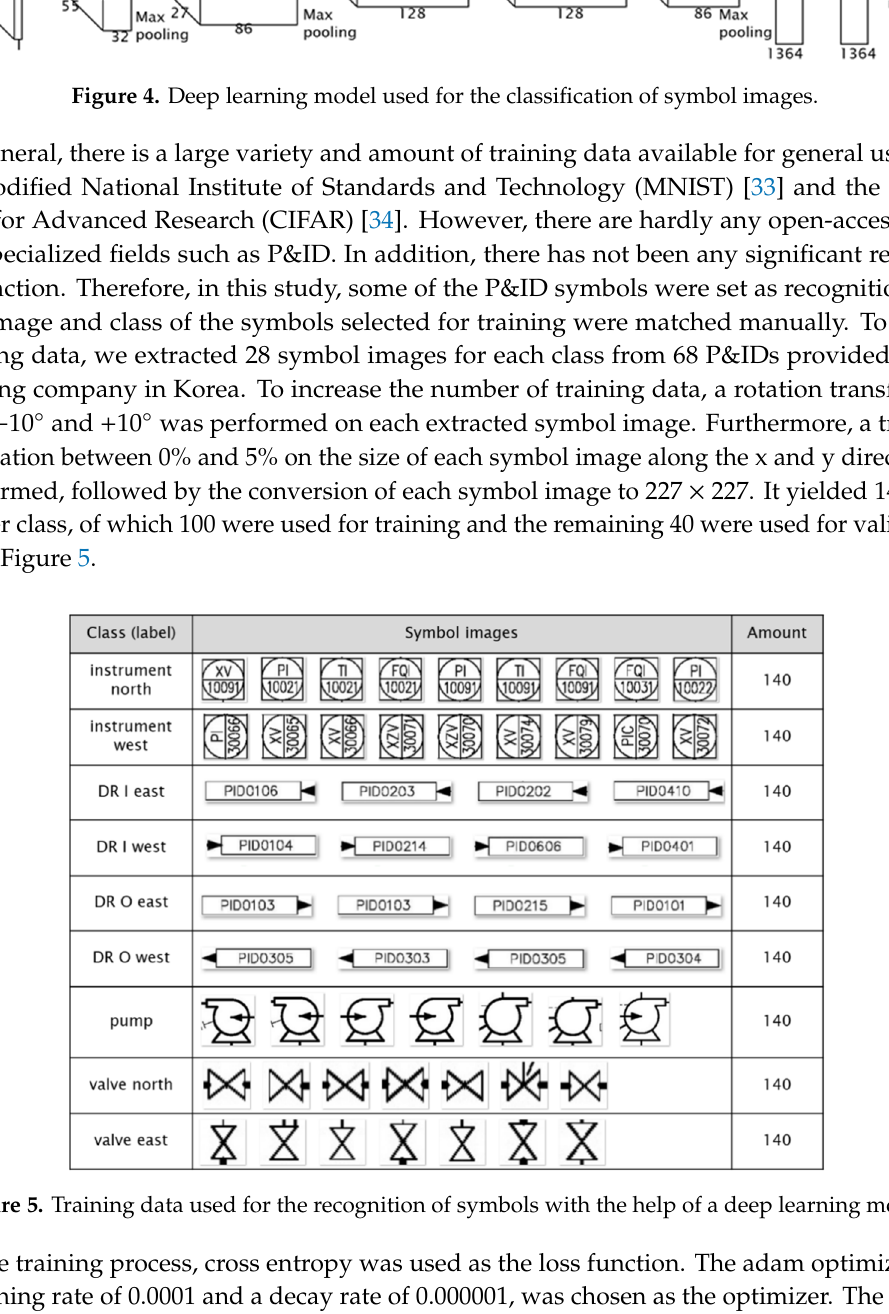
Figure 4. Deep learning model used for the classification of symbol images.